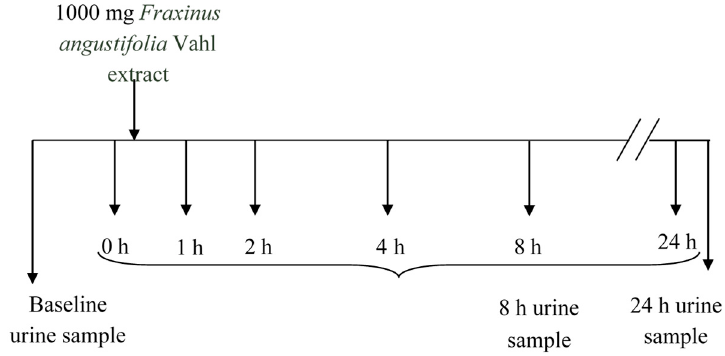
Figure 7. Experimental design and sampling protocol.